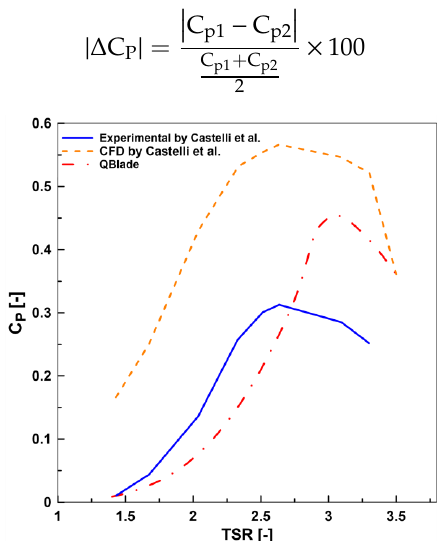
Table 2. Comparison of C P from experiment, CFD, Qblade and their relative deviation TSR Figure 8. Comparison of power coe ffi cient versus experiment and numerical results by Raciti Figure 8. Comparison of power coefficient versus experiment and numerical results by Raciti Castelli Castelli et al. [35]. et al. [35].